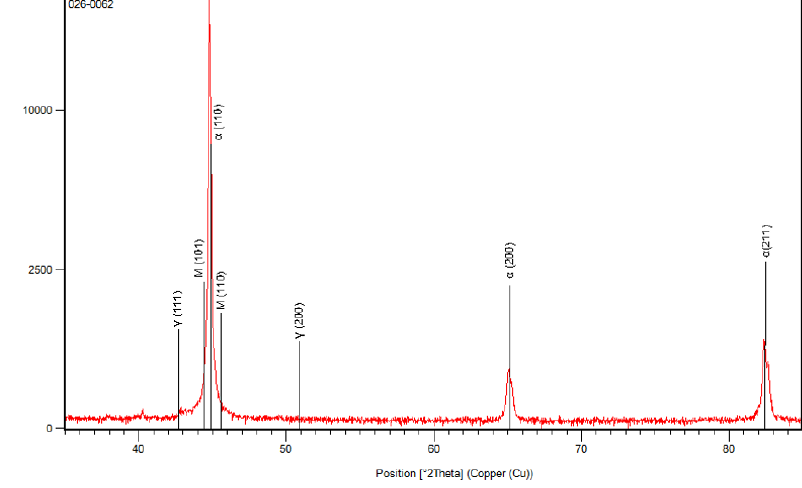
Figure 10: Diffraction pattern for sample welded by S-SAW.